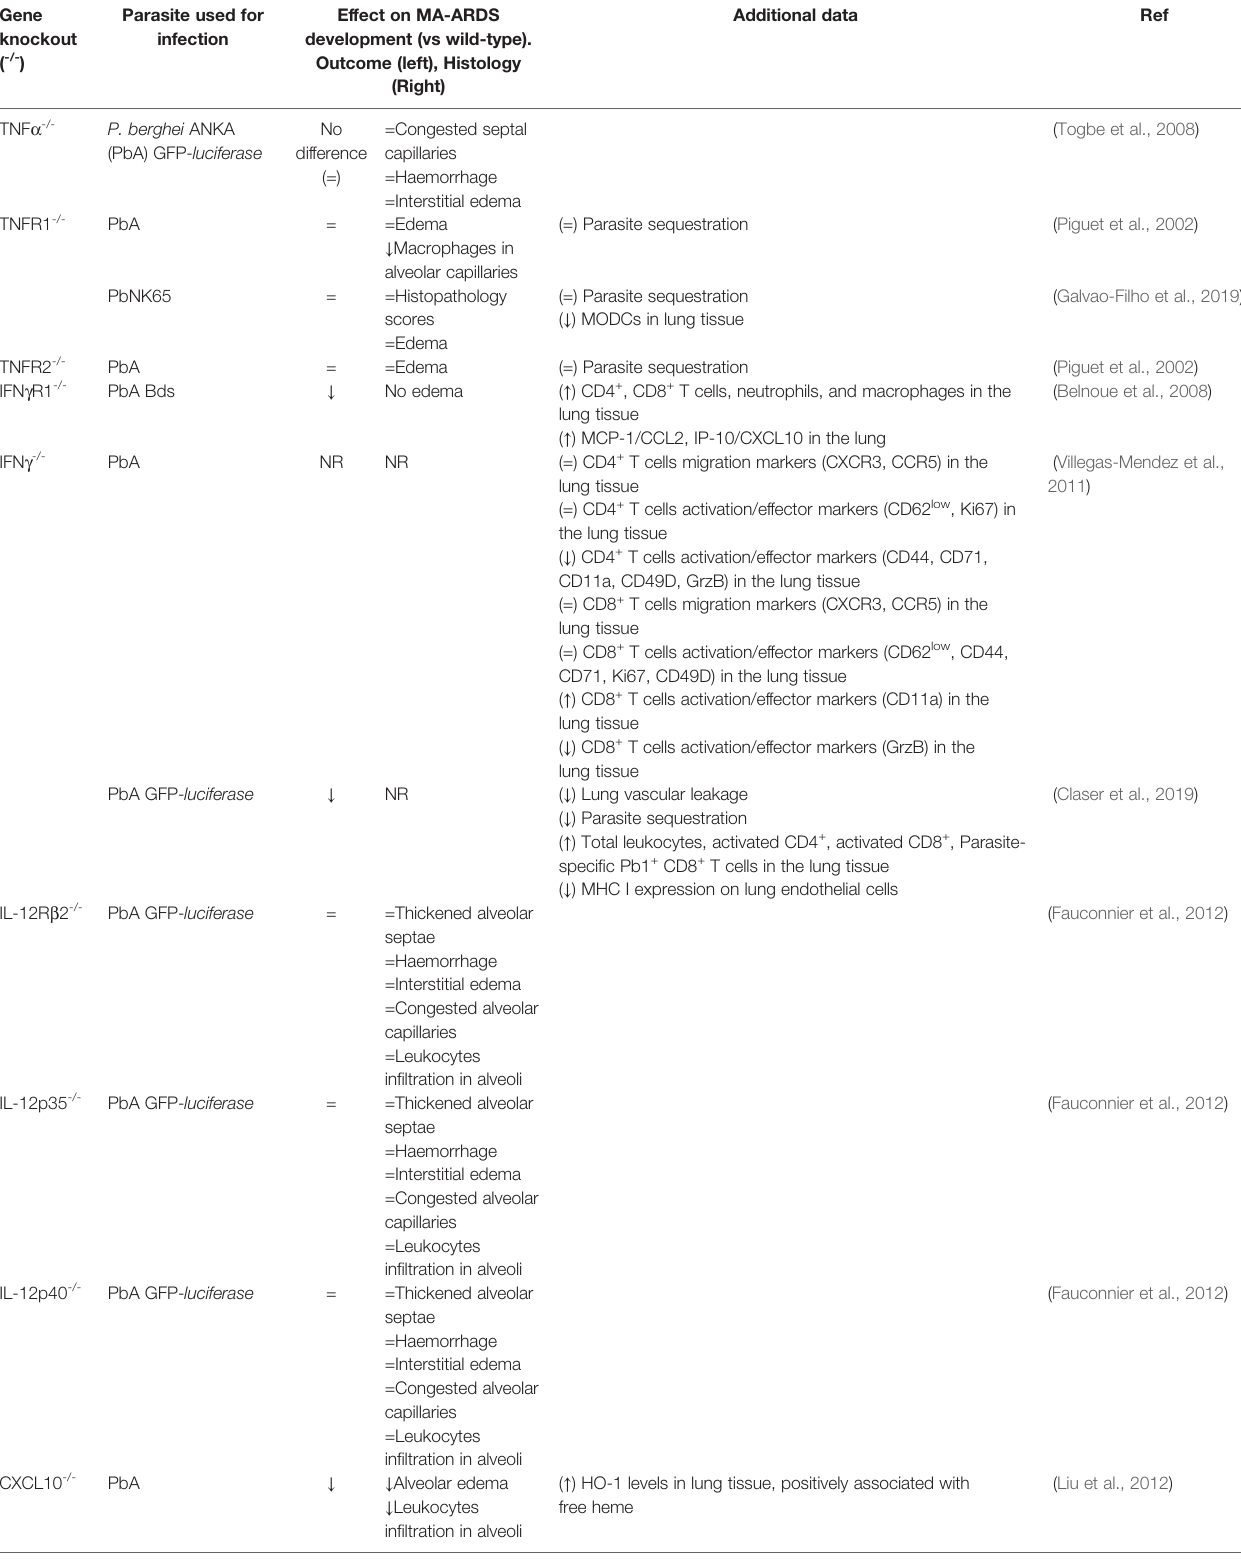
TABLE 2 | The role of cytokines/chemokines ligand-receptors in experimental MA-ARDS. Gene Parasite used for Effect on MA-ARDS knockout infection development (vs